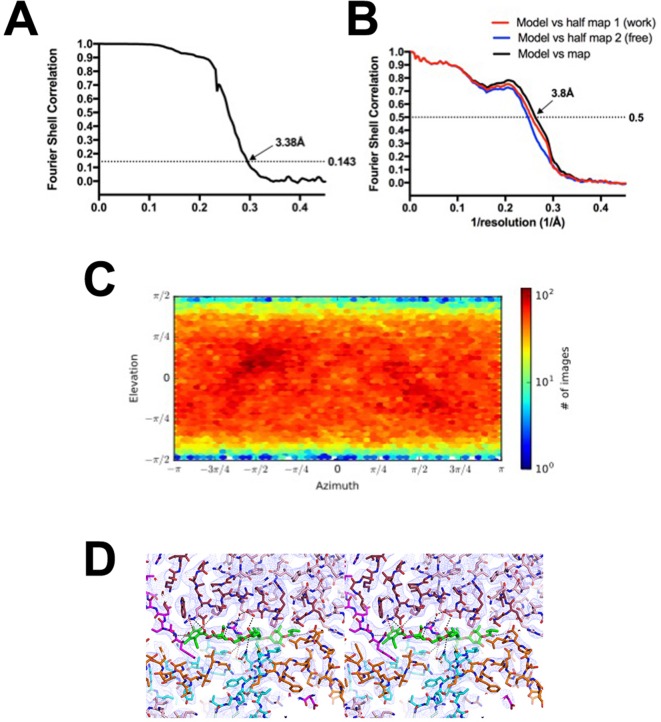
Fdx/RbpA/σA-holo/us-fork class.(A) Gold-standard FSC (Rosenthal and Henderson, 2003), calculated by comparing the two independently determined half-maps from cryoSPARC. The dotted line represents the 0.143 FSC cutoff which indicates a nominal resolution of 3.38 Å. (B) FSC calculated between the refined structure and the half map used for refinement (work, red), the other half map (free, blue), and the full map (black). (C) Angular distribution calculated in cryoSPARC for particle projections. Heat map shows number of particles for each viewing angle (less = blue, more = red). (D) Stereo view of the Fdx binding pocket with cryo-EM density (blue mesh) superimposed.